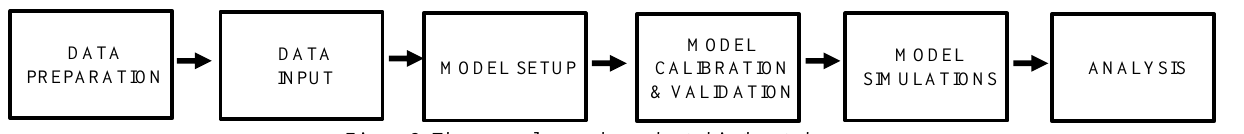
Figure 2. The general procedure adopted in the study.